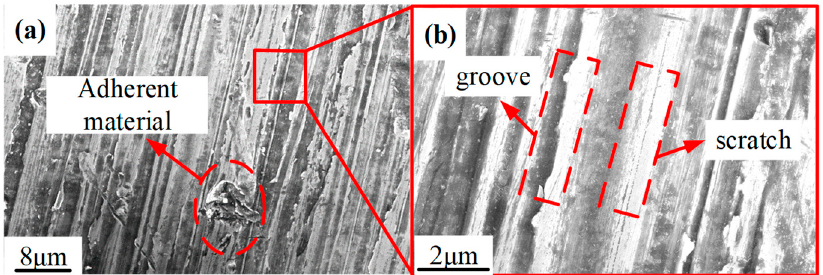
Figure 12. SEM photograph of Ti-6Al-4V alloy after grinding: ( a ) Adherent material on titanium alloy